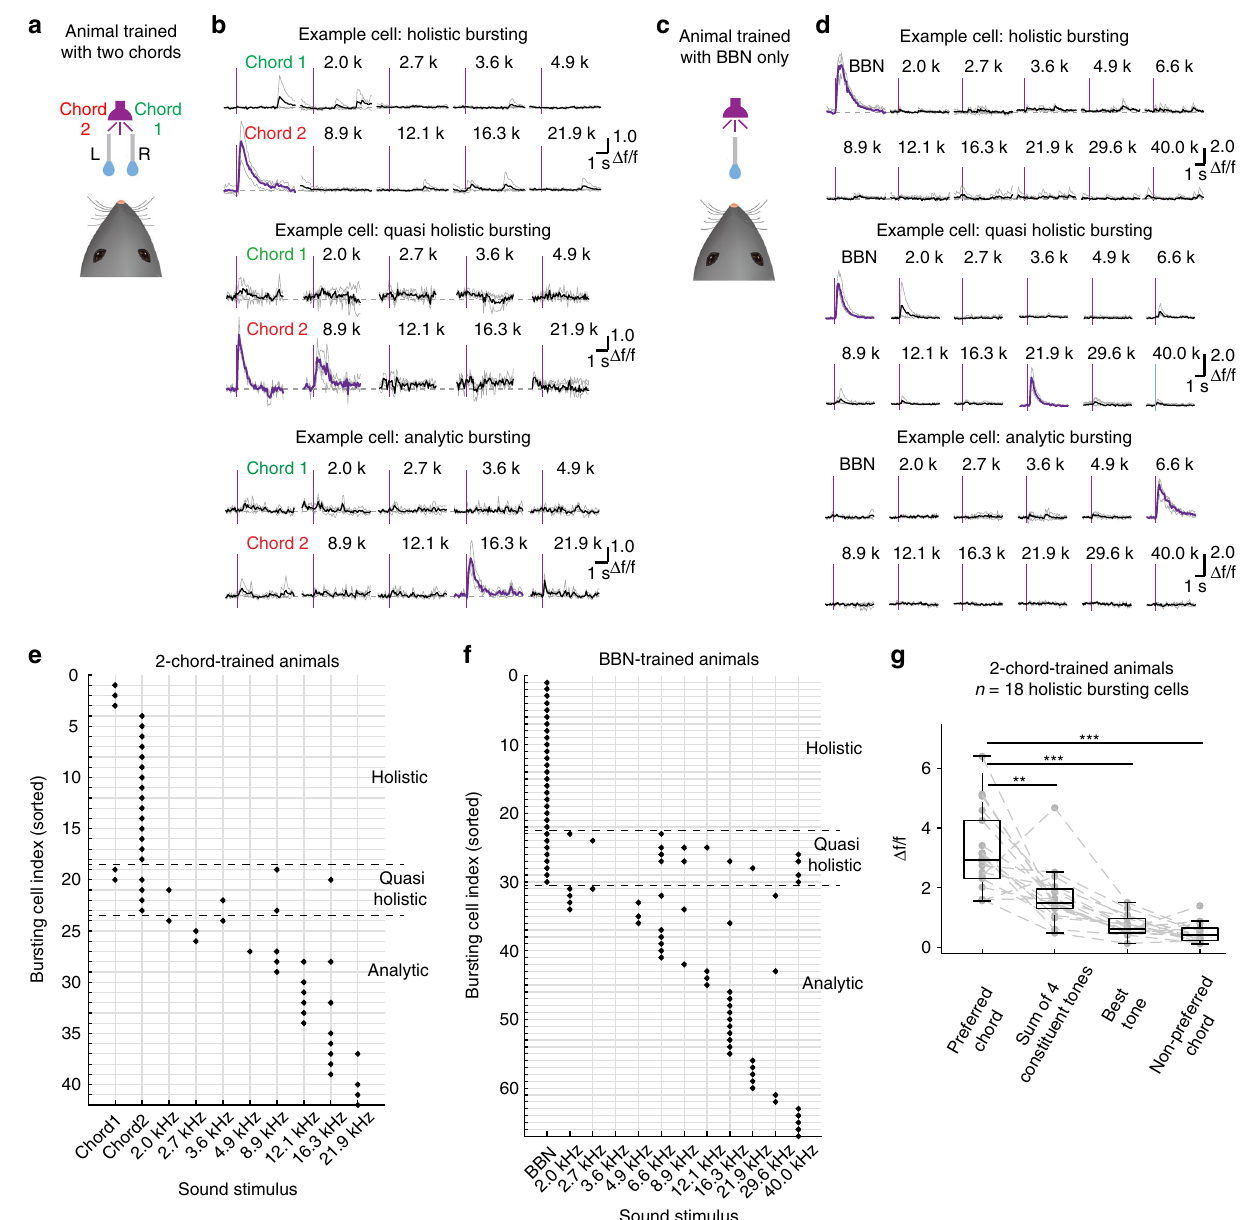
Fig. 6 Holistic, quasi-holistic and analytic bursting cells in animals trained with complex sounds. a Cartoon showing a 2-chord-trained animal. b Ca 2 + signals evoked by different sound stimuli using each chord and each pure tone for three example cells. Single trials (grey traces) and their averages (black and purple traces) are overlaid. Vertical bars indicate sound stimulus onset time. c , d Similar arrangement as in panels a and b showing different example cells from BBN-trained mice. e Summary for holistic, quasi-holistic and AB responsive cells identi fi ed out of 570 cells (pooled from all 19 imaging FOVs in 7 chord-trained animals tested with the two chords and 8 constituent tones); each dot represents the bursting response (trial-averaged Ca 2 + response amplitude, Δ f / f (Cal-520) ≥ 1.5) to the corresponding stimulus. f Same arrangement as panel e ; the summary for bursting responsive cells out of a total of 681 cells (from all 22 imaging FOVs in 6 BBN-trained animals that were tested with BBN and pure-tone stimuli). g Comparing the response to the chord with the responses to constituent tones in the 2-chord-trained mice. Each data point represents the trial-averaged Ca 2 + response amplitude for a certain category. Sum of four constituent tones means summing the responses evoked by each of the four constituent tones that correspond to the preferred chord. Datapoints for each cell were individually calculated (i.e., the preferred chord could be a different one, or summing different tone responses), P = 0.0099 (chord versus sum of 4 tones), P = 5.88e − 4 (chord versus best tone), P = 5.88e − 4 (chord versus non-preferred chord), two-sided Wilcoxon signed-rank test, Bonferroni corrected, n = 18 cells. *** P < 0.001, ** P < 0.01. Boxes represent Q1 and Q3, central bars indicate the median, and whiskers indicate Q1-1.5 × IQR and Q3 + 1.5 ×